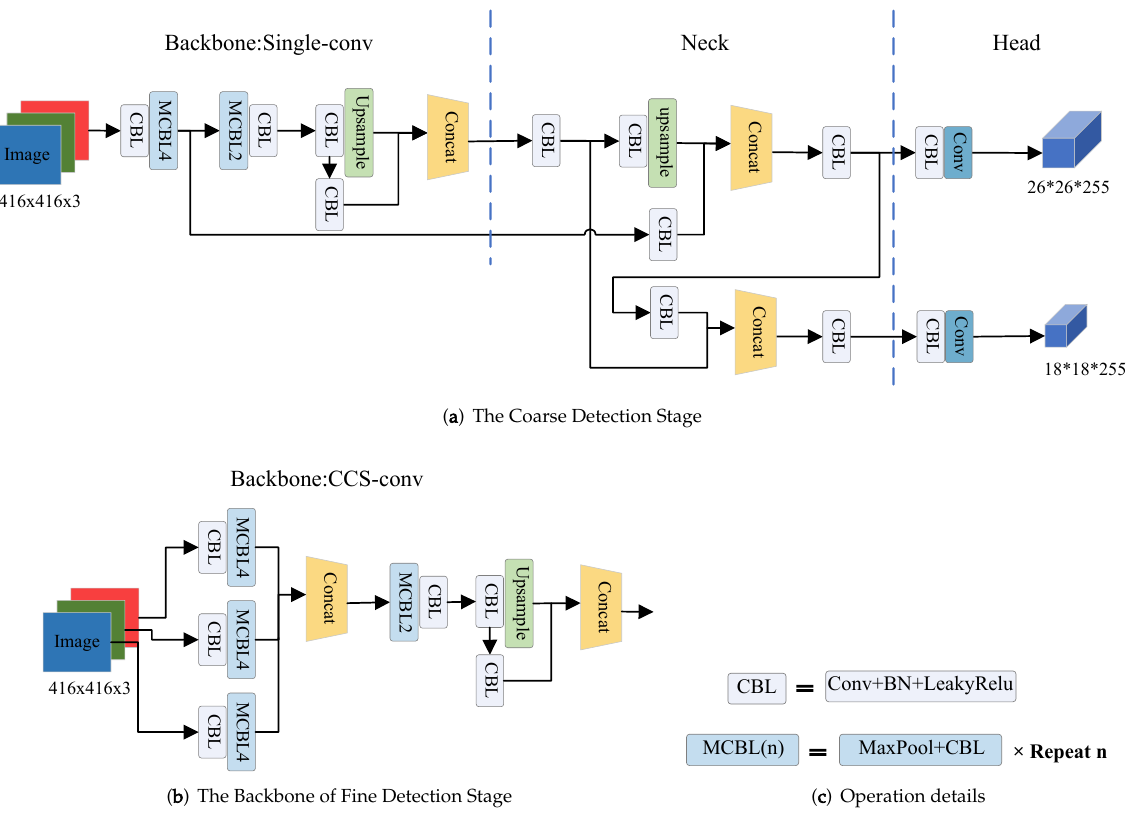
Figure 2. Flowchart of proposed optical glass defect detection methods. First of all, multi perspectives images are extracted from the videos of optical glass. Then glass detection stage takes these images as input to find the locations of optical glass. The detected regions with good image quality will be fed into the defect detection stage. Finally, the fusing module is proposed to integrate the results from different perspectives to get the final defect detection result.